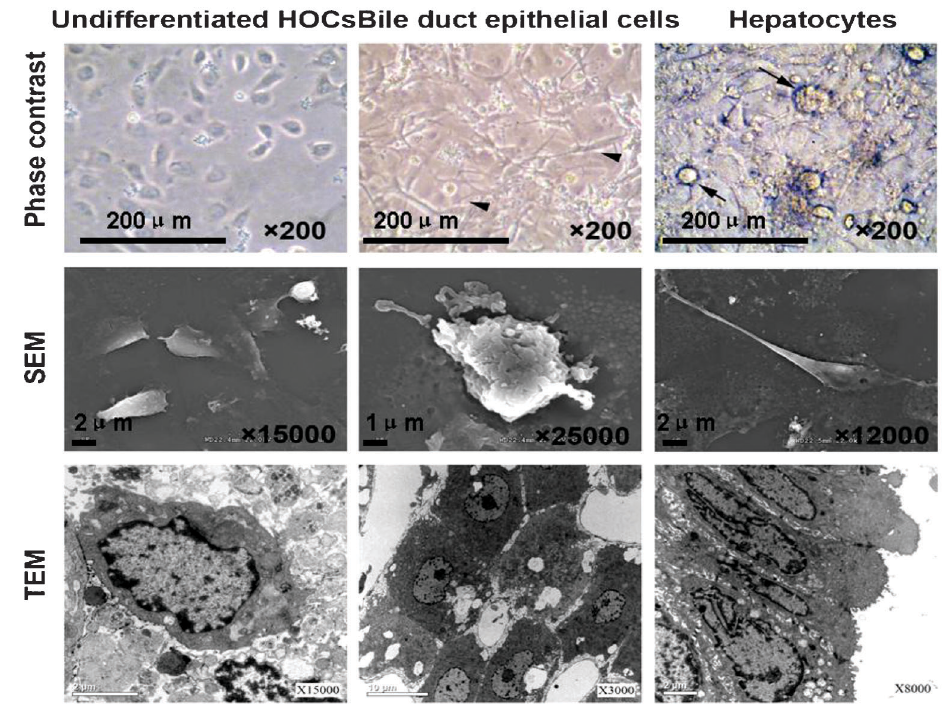
Figure 2. Differentiation capabilities of hepatic oval cells (HOCs). Leukemia inhibitory factor (LIF) was withdrawn from the culture medium to induce cell differentiation for 3 days. Passage-4 HOCs were used for differentiation. Undifferentiated or differentiated cells were monitored by phase contrast microscopy, scanning electronic microscopy (SEM), or transmission electron microscopy (TEM). Arrowhead: a long spindle-like bile duct epithelial cell; arrow: a large round-shaped hepatocyte.